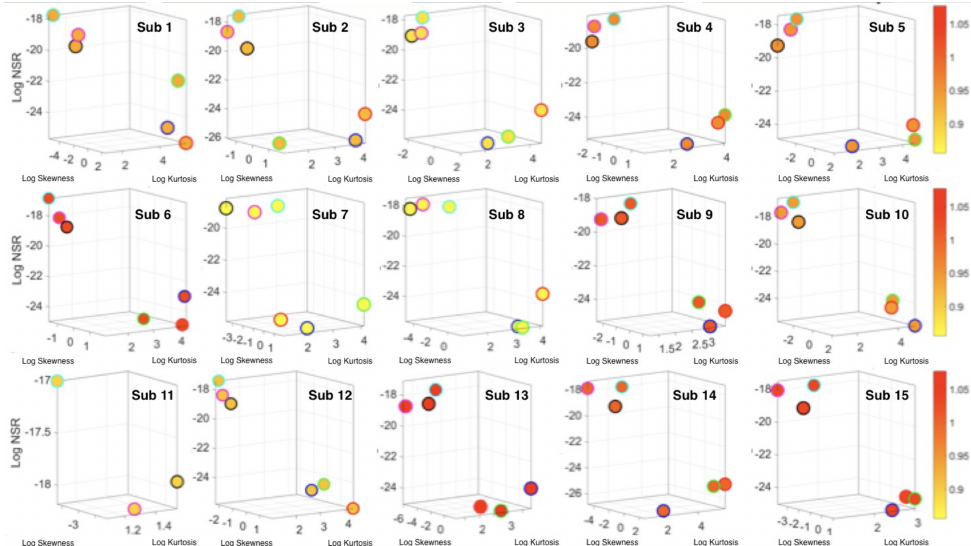
Figure A4. Remaining participants 15/30 from the full Kaggle.com cohort in Figure 5 of the main